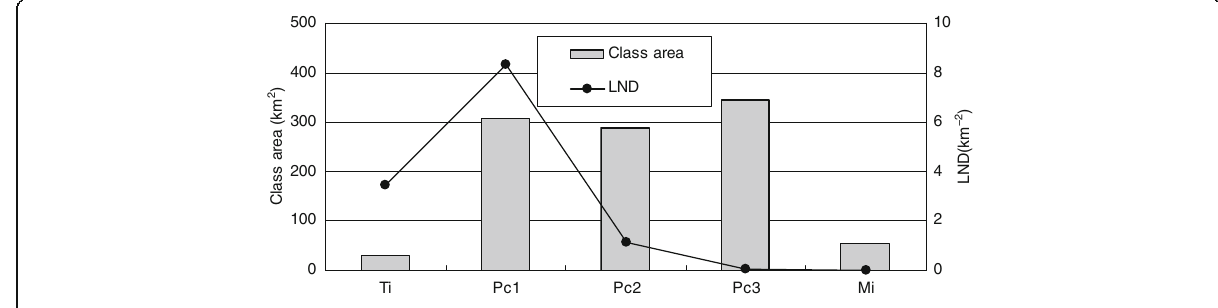
Fig. 13 Same as Fig. 10 but for lithology ( horizontal axis)